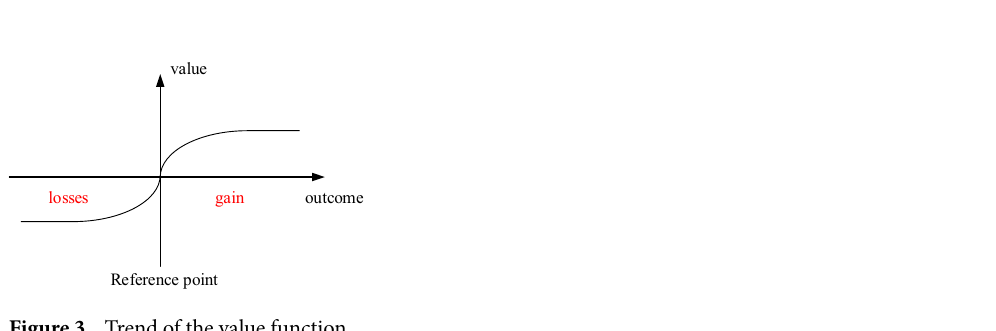
Figure 2. Basic procedures of A-DRE.